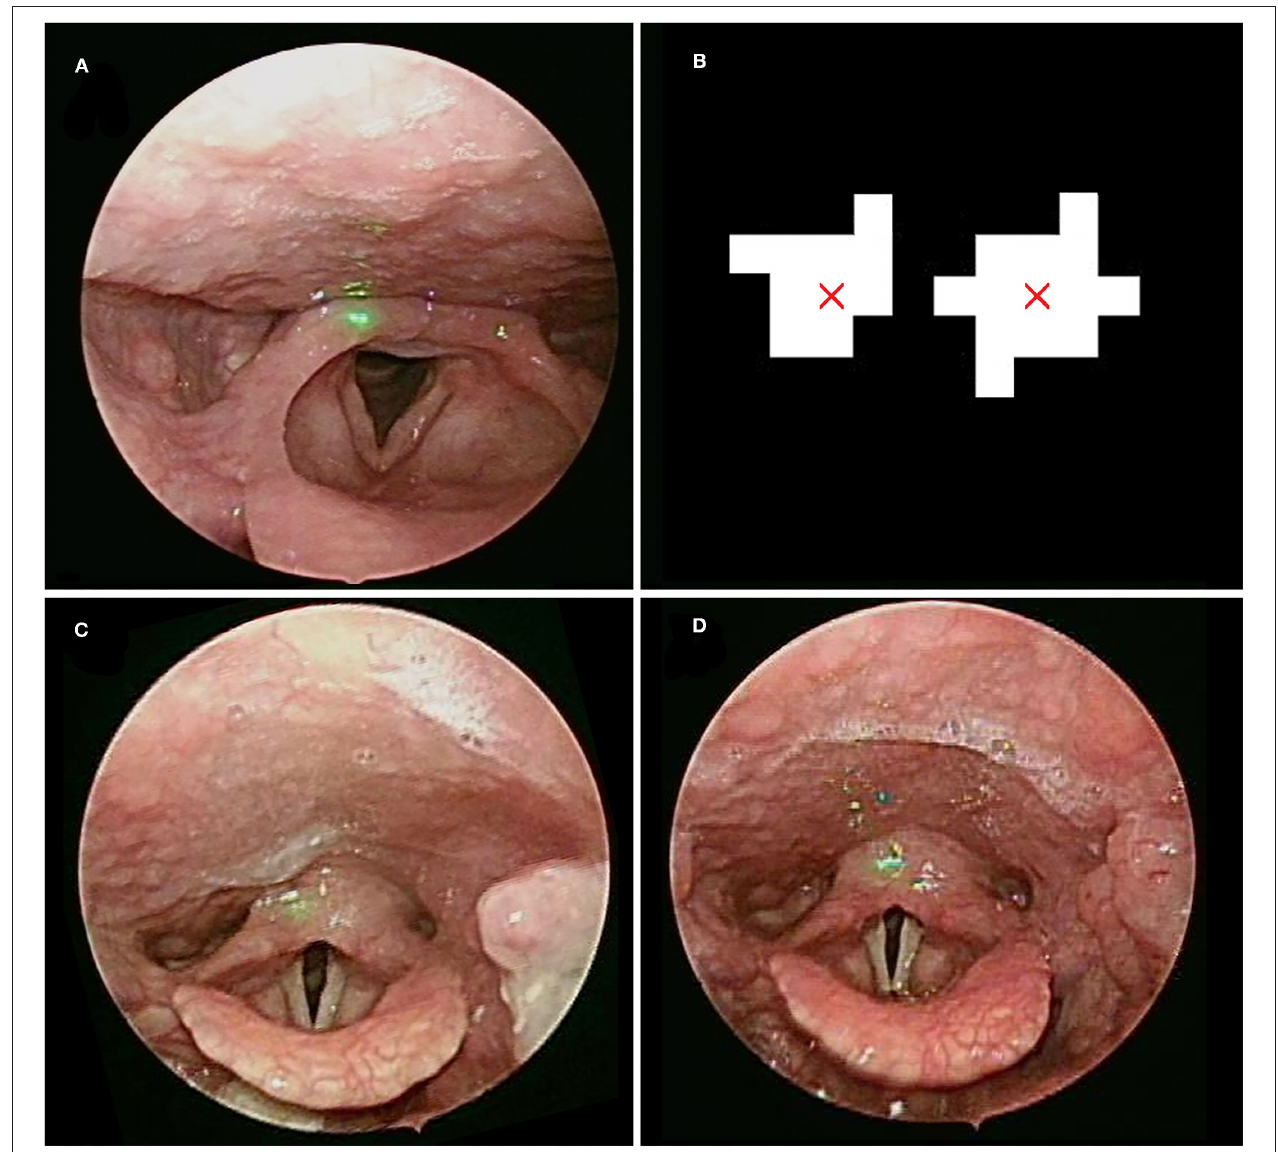
FIGURE 1 | (A) The laser beams projected on the healthy control subject. (B) Image processing defines the center of the laser dot and gives us its equivalent distance as 1mm. The laryngeal images before (C) and after (D) general anesthesia with intubation.